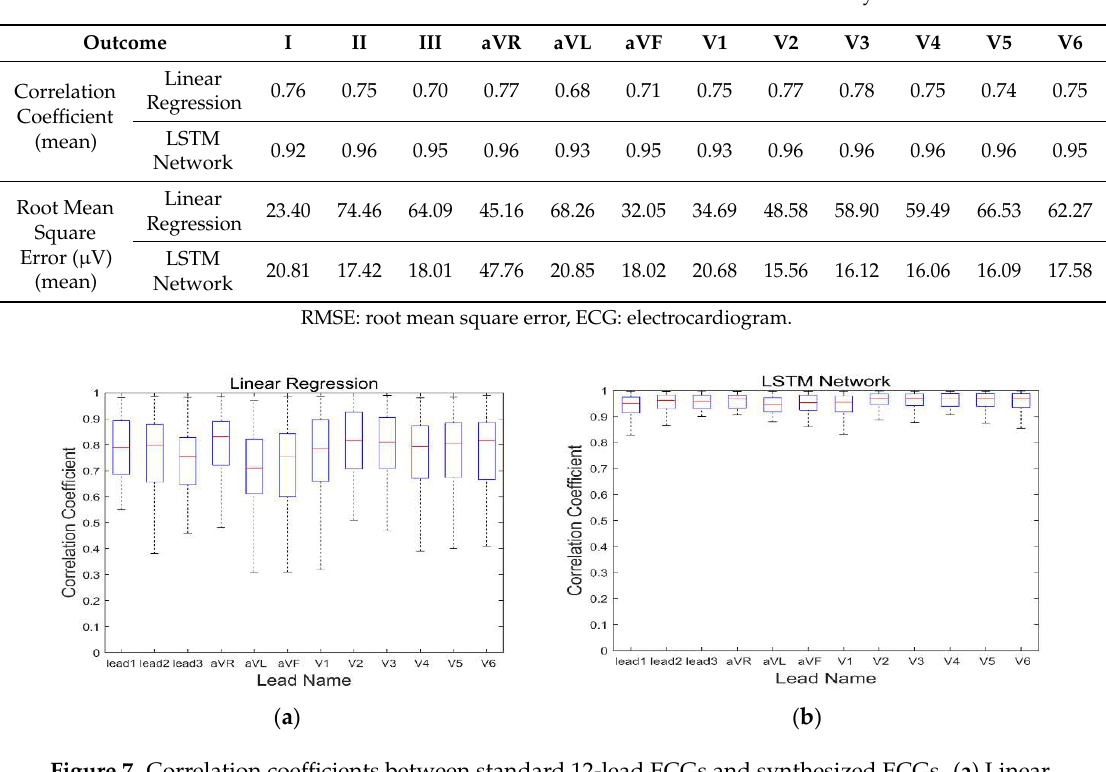
Table 1. Mean correlation coe ffi cients and RMSE between standard 12-lead and synthesized ECGs.